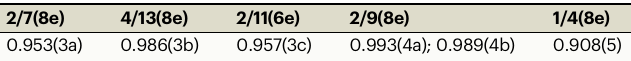
Table3|Theoverlapbetweenthegroundstateswithdifferent fi lling factors ( fi rst row) of the corresponding model Hamil-